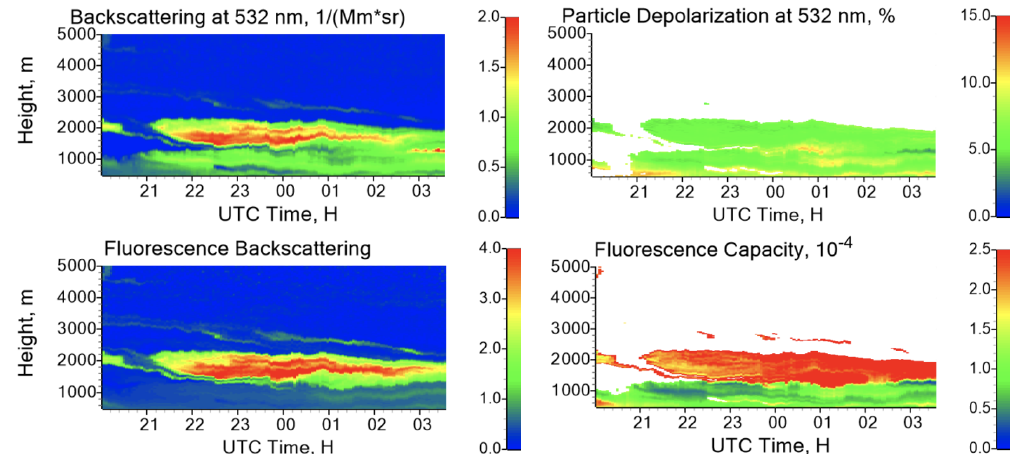
Figure 14. Spatiotemporal distributions of the backscattering coefficient β 532 , the fluorescence backscattering coefficient β F (in 10 − 4 Mm − 1 sr − 1 ), the particle depolarization ratio δ 532 , and the fluorescence capacity G F on the night of 11–12 August 2021. The val- ues of δ 532 and G F are shown for β 532 > 0.3Mm − 1 sr − 1 .